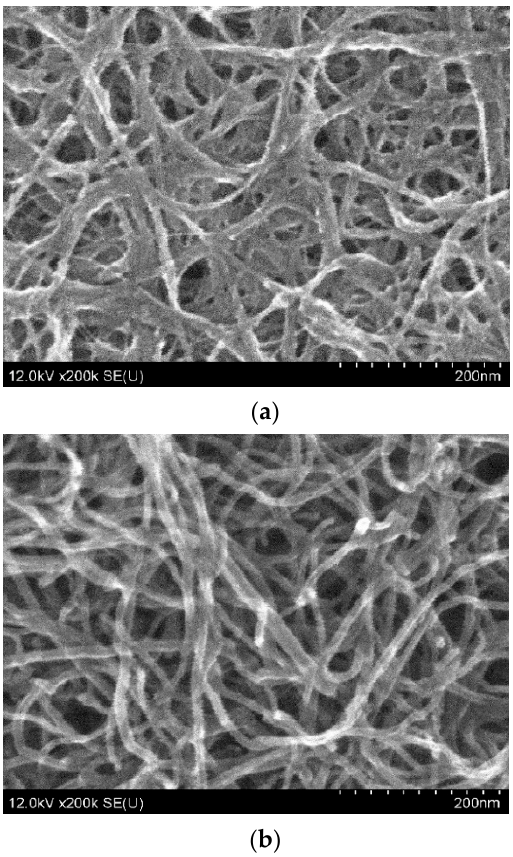
Figure 3. Scanning electron microscope (SEM) images of the produced ( a ) SWCNT and ( b ) MWCNT. It is assumed that the large density of SWNT film prevented a complete removal of the surfactant from its surface. Raman spectra of CNTs (see Figure 4) show a low (0.08) and a high (0.86) ratio of D-mode to G-mode intensities for SWCNT and MWCNT films,